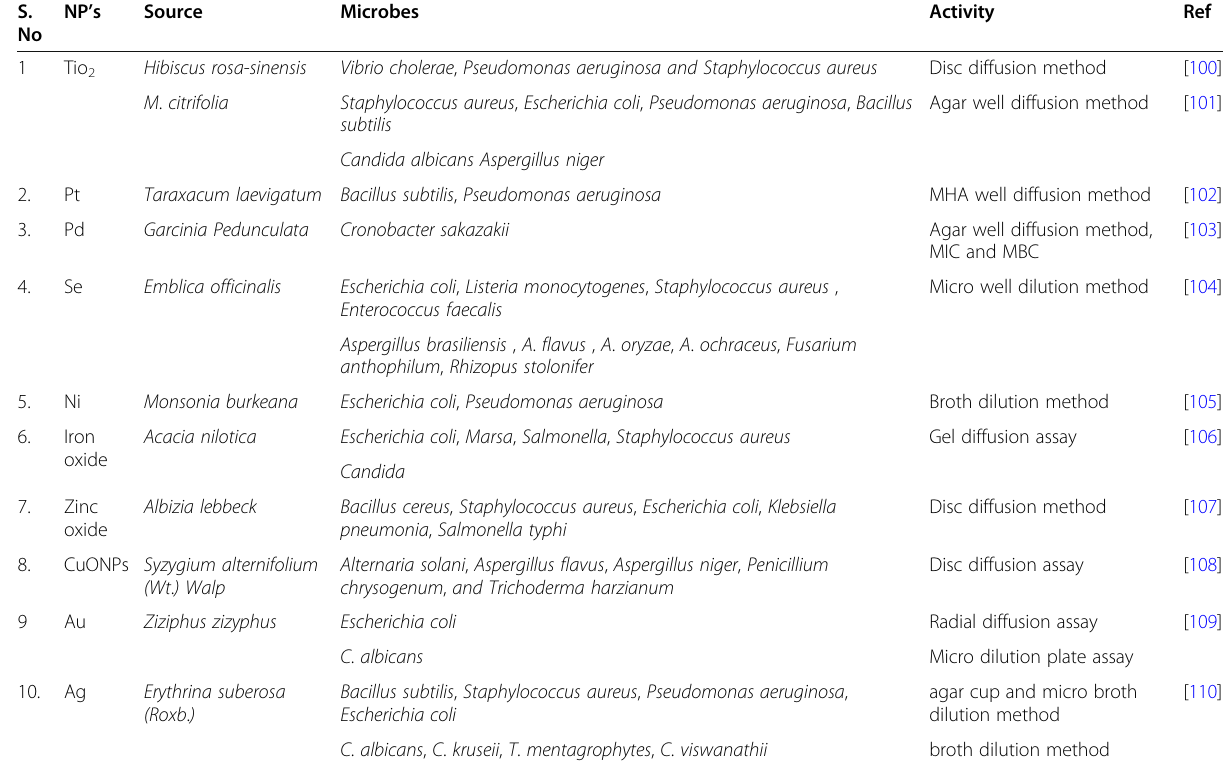
Table 4 Antimicrobial activity of biological metal nanoparticles S. NP ’ No